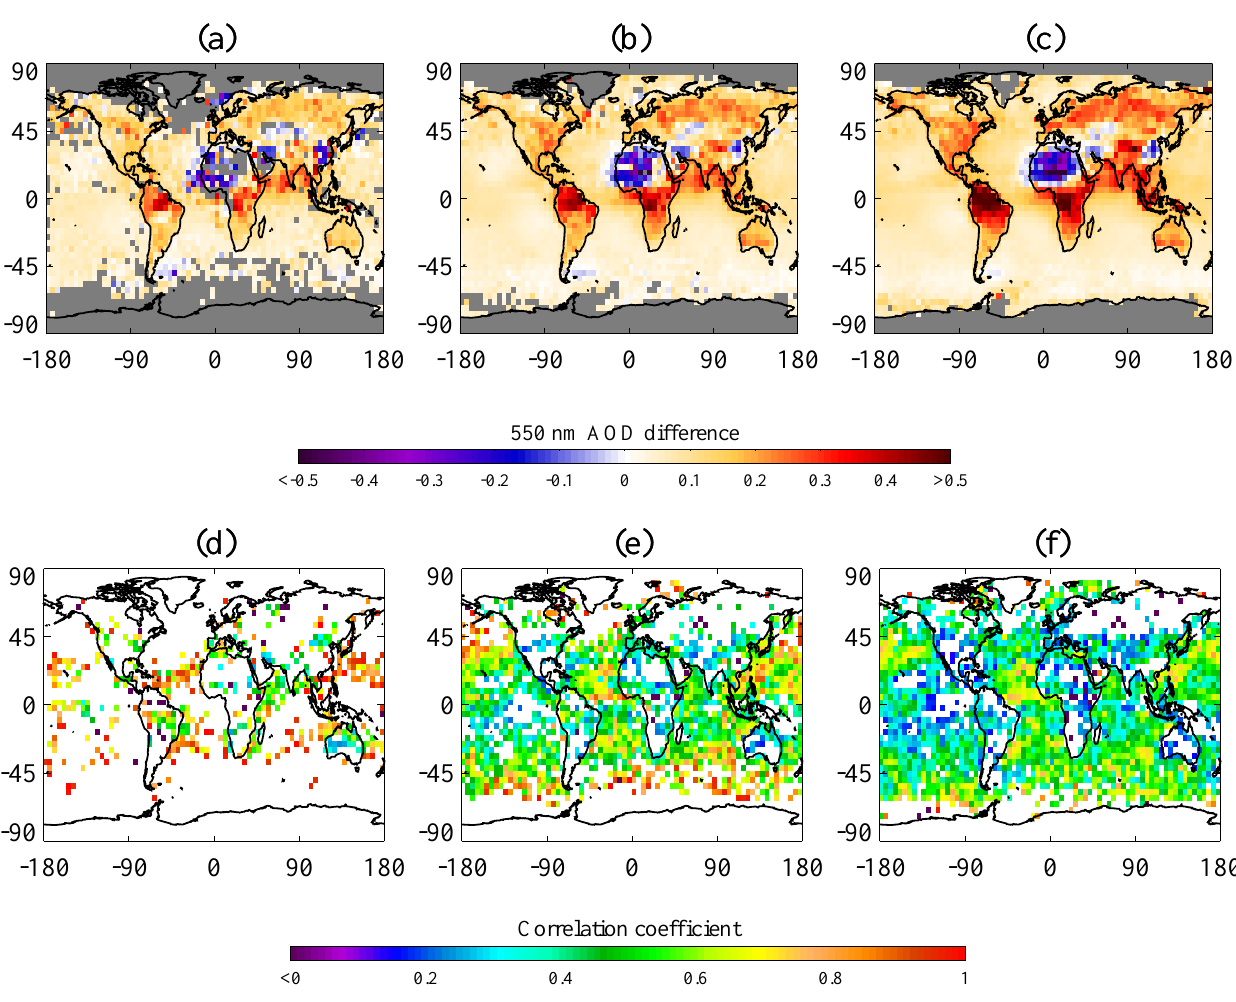
Fig. 8. Comparison between GlobAerosol AATSR and GEOS-Chem annual mean AOD fields as a function of data sparsity threshold. The AATSR data are constructed from daily mean fields (left column of Fig. 7). From left to right, the columns indicate fields where GEOS-Chem grid cells are at least 25% filled by GlobAerosol data; at least 5% filled; and contain any GlobAerosol data. The first row shows (a, b, c) the (satellite-model) difference in annual mean AOD for the three thresholds, and the second row (d, e, f) Pearson’s correlation coefficient r where significant at the 90%